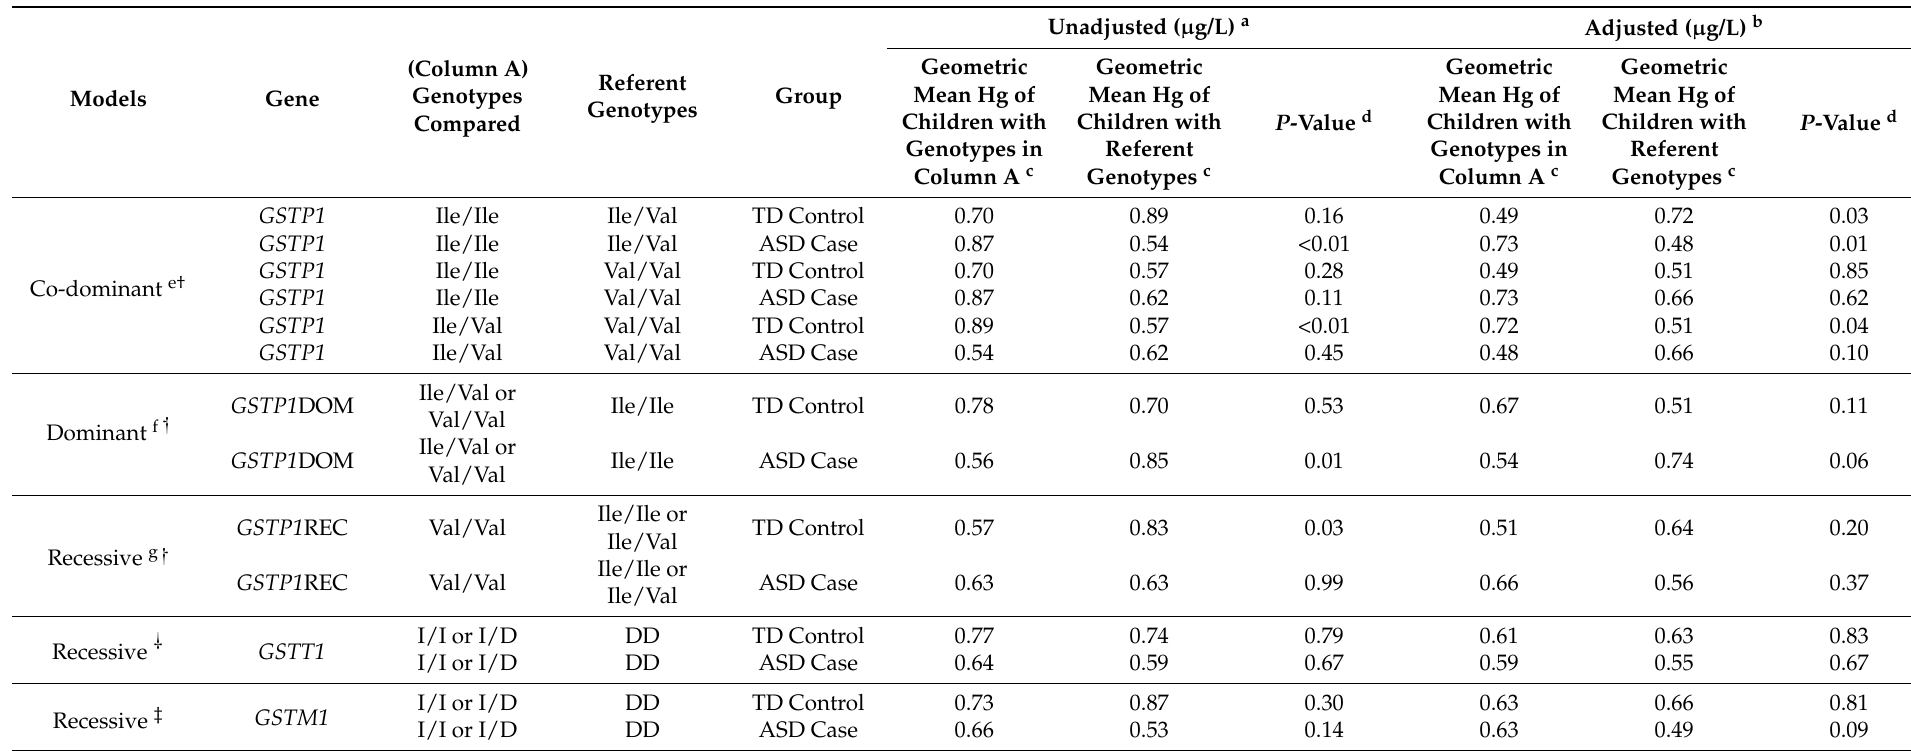
Table 4. Unadjusted and adjusted geometric mean blood mercury concentrations by GST genotypes based on General Linear Models (GLM) that include interaction between GST genes and ASD case status (ASD and TD control)